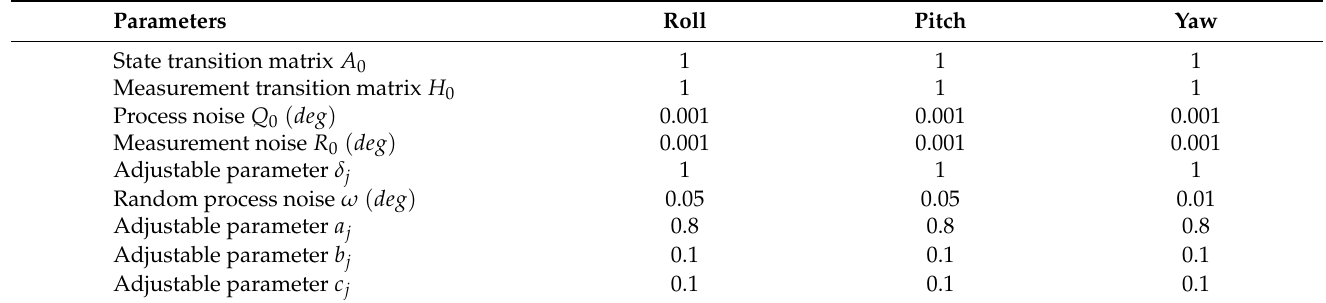
Table 5. Parameters of attitude estimation for suppressing maneuvering acceleration